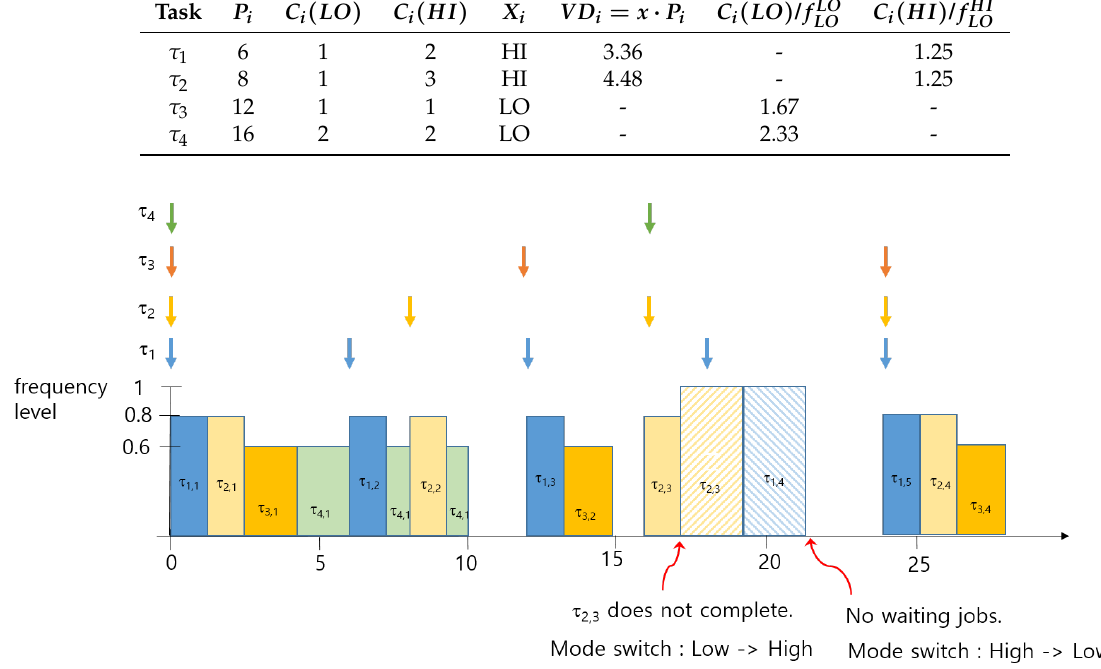
Figure 3. An example of power-aware mixed-criticality Scheduling of Table